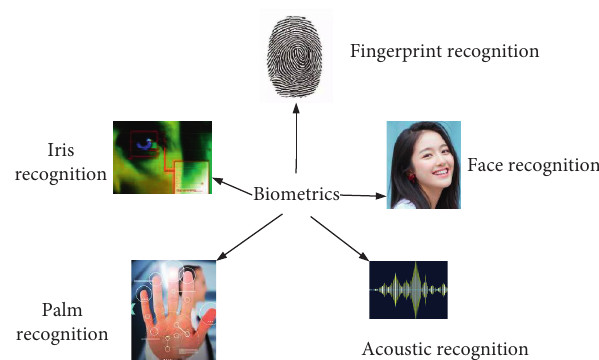
Figure 1: Commonly used biological